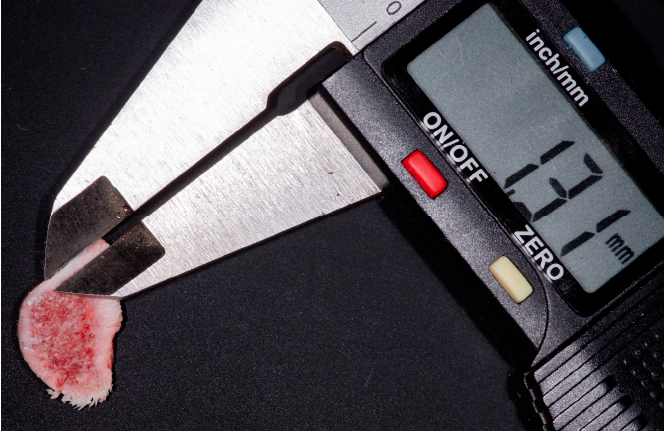
Figure 1. Porcine rib model used for the in vitro experiment with a cortical bone thickness of 1.31 mm.